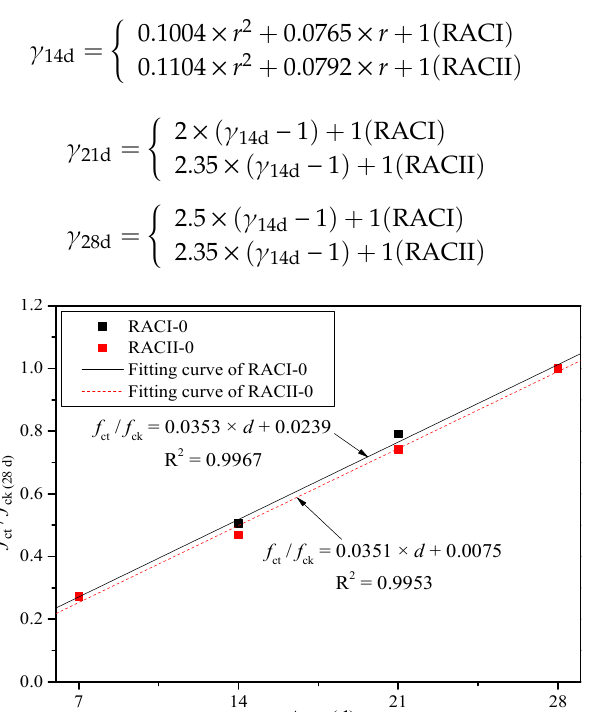
Figure 8. Fitting curve of coefficient α.